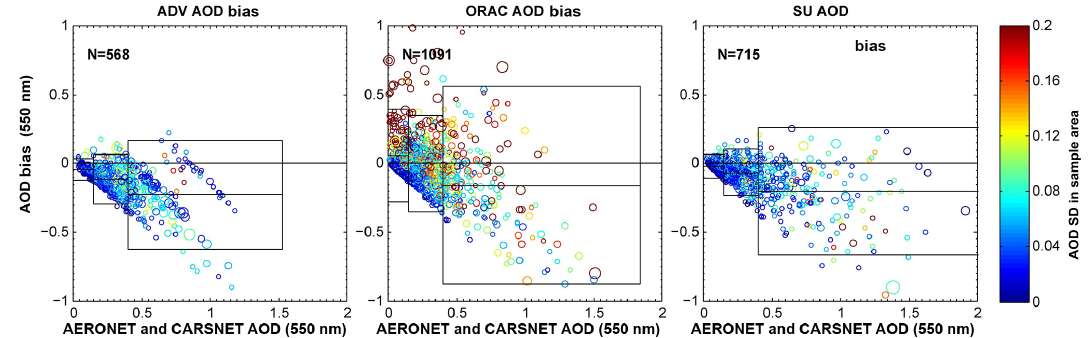
Figure 3. Scatter plot of AERONET and CARSNET AODs with ADV AOD bias or uncertainties in China in 2007, 2008, and 2010. The areas and colours of bubbles represent MU and Std_S sampling area of 50km × 50km, respectively. Colours represent different groups: blue denotes light loading, green denotes moderate loading, and red denotes heavy loading. Each group has one box, the bottom and top borders of which represent MBE + 2 σ and MBE − 2 σ , respectively, containing 96% of scattered points of each group. The centre line of each box represents the MBE of each